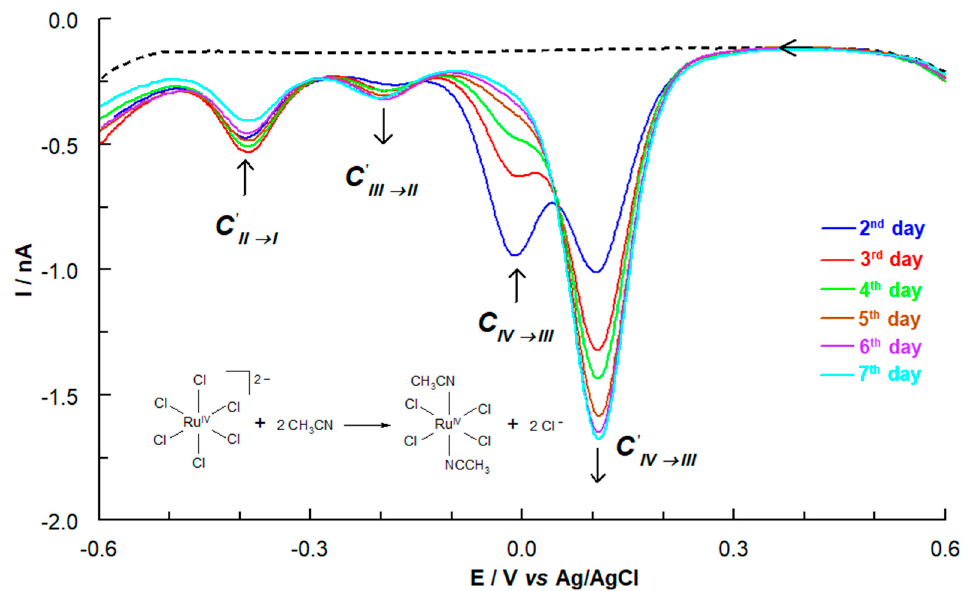
Figure 8. Periodically recorded DPV curves for complex 1 . The presented curves were performed up to 7 days from the preparation of the solution. Conditions as shown in Figure 7.